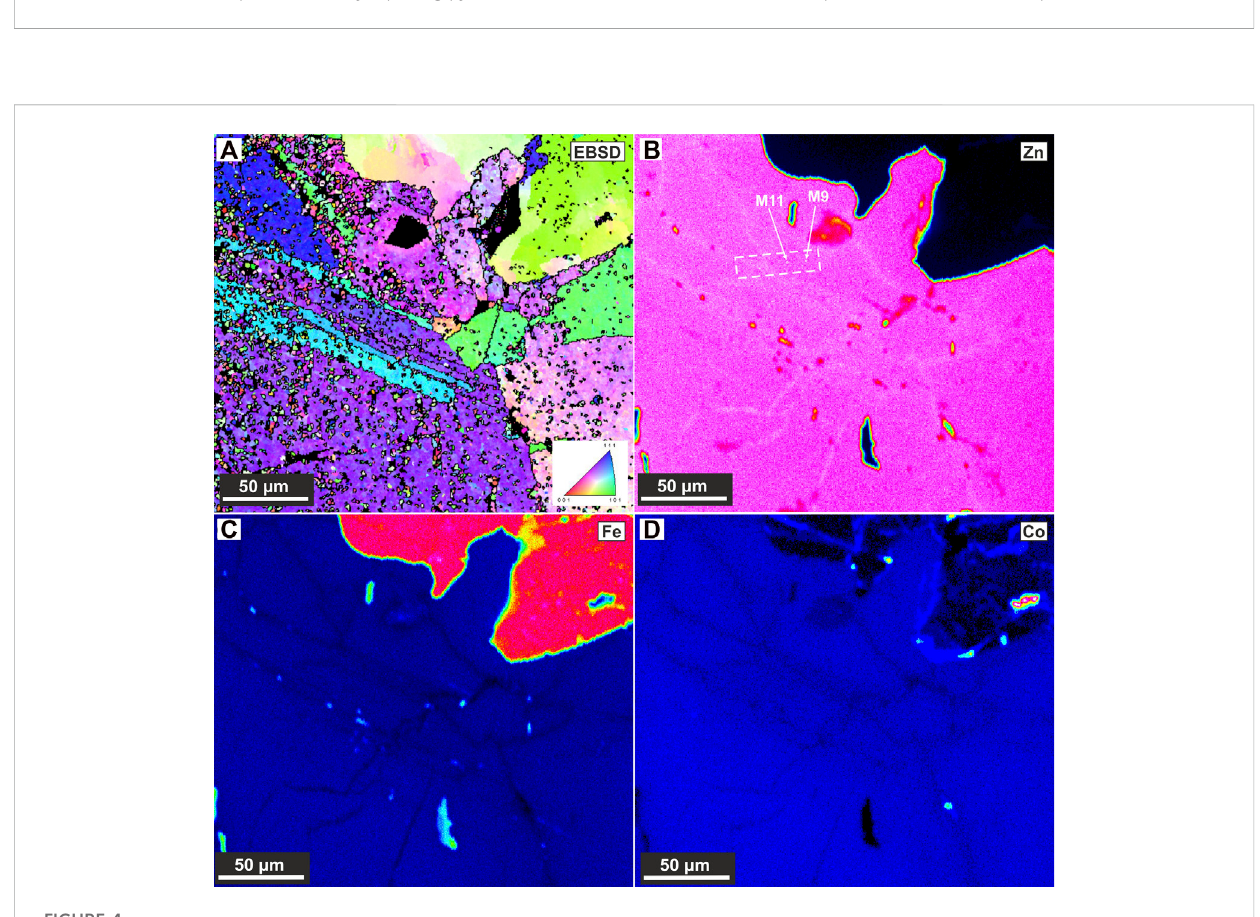
FIGURE 4 SEM-EBSDgrainmisorientationmapovertheinvestigatedarea (A) .EPMAelementmapsofthesameareaas (A) ,showingZn,Fe,andCodistributions [ (B – D) respectively]. Positions of the two successful APT samples are marked out in (B) , within dashed lines making the lift-out